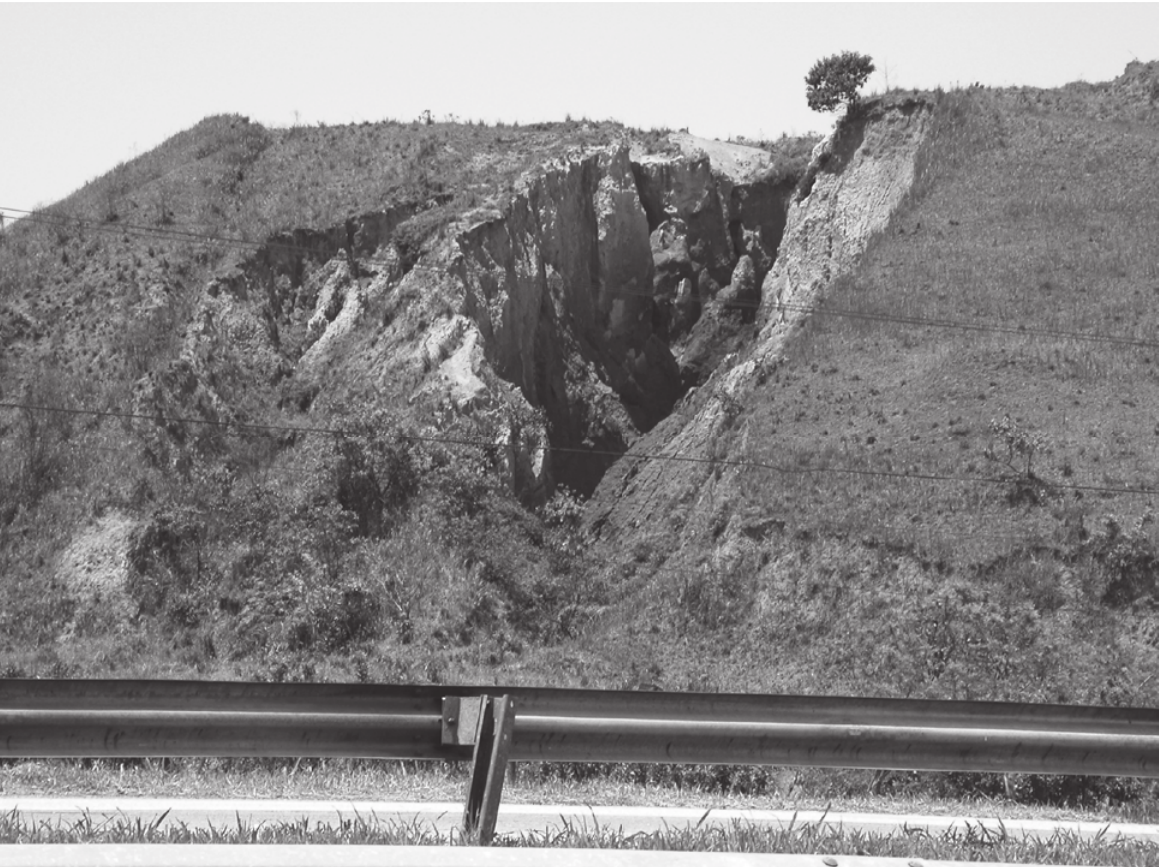
Figure 9 - Deep gully along the state road RJ-122 in the municipality of Cachoeiras de